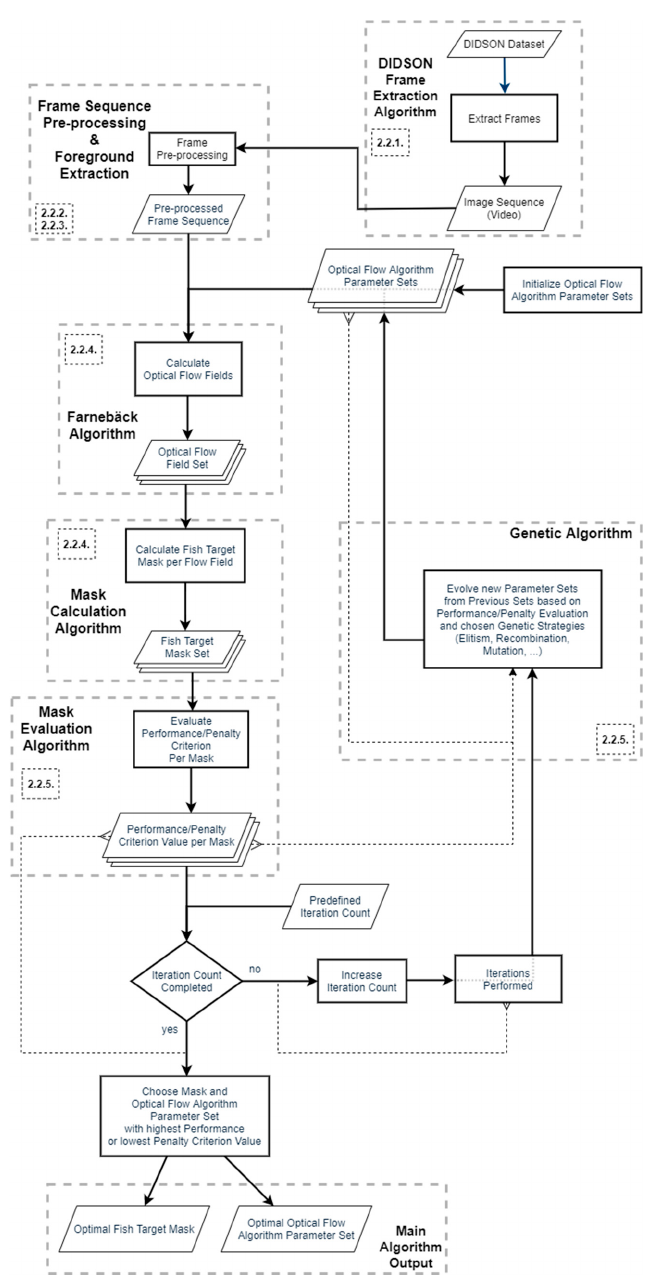
Figure 2. Flow chart depicting the proposed procedure for fish-target mask extraction from raw DIDSON data, i.e., the data pre-processing step and the iterative part, which utilizes the optical flow calculation and a genetic algorithm to extract an optimal foreground mask for subsequent target detections.